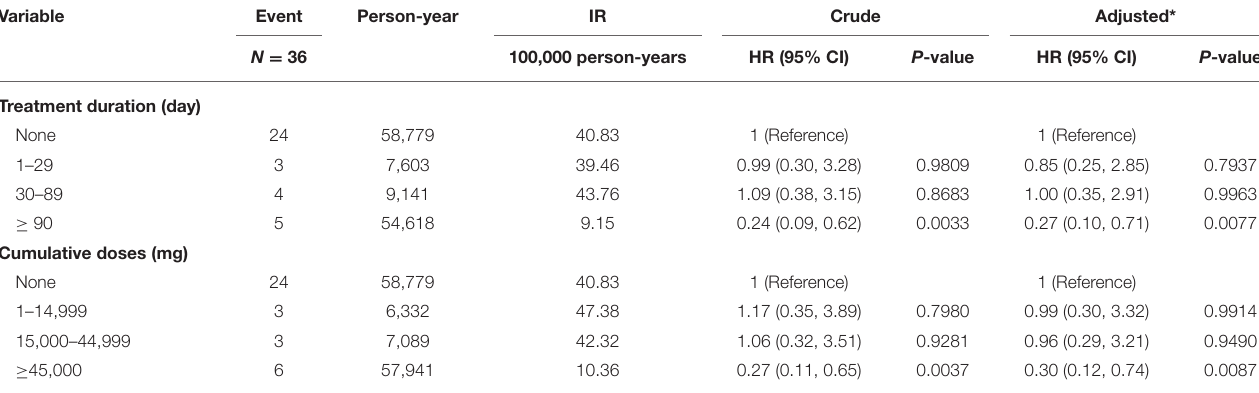
TABLE 4 | Cox regression analyses of Sjögren’s syndrome associated with different treatment duration and cumulative doses of metformin in type 2 diabetic patients. Variable